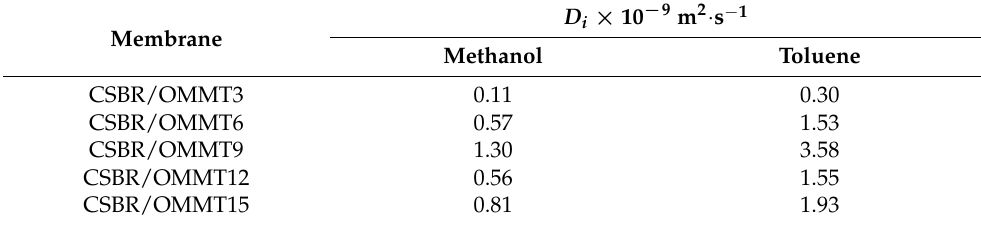
Table 9. Apparent diffusion coefficient of CSBR/OMMT nanocomposite membranes.